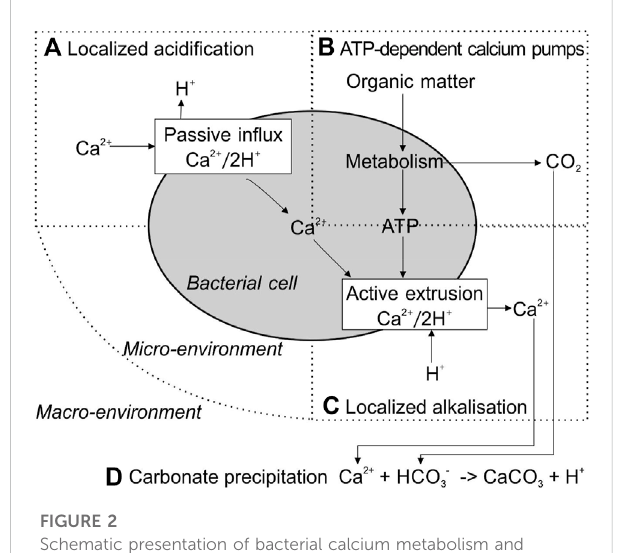
FIGURE 2 Schematic presentation of bacterial calcium metabolism and subsequent CaCO 3 precipitation under high-Ca 2+ extracellular conditions. Revised from Hammes et al. (2002). (A) Localized acidi fi cation; (B) ATP-dependent calcium pumps; (C) Localized alkalisation:(D) Carbonate